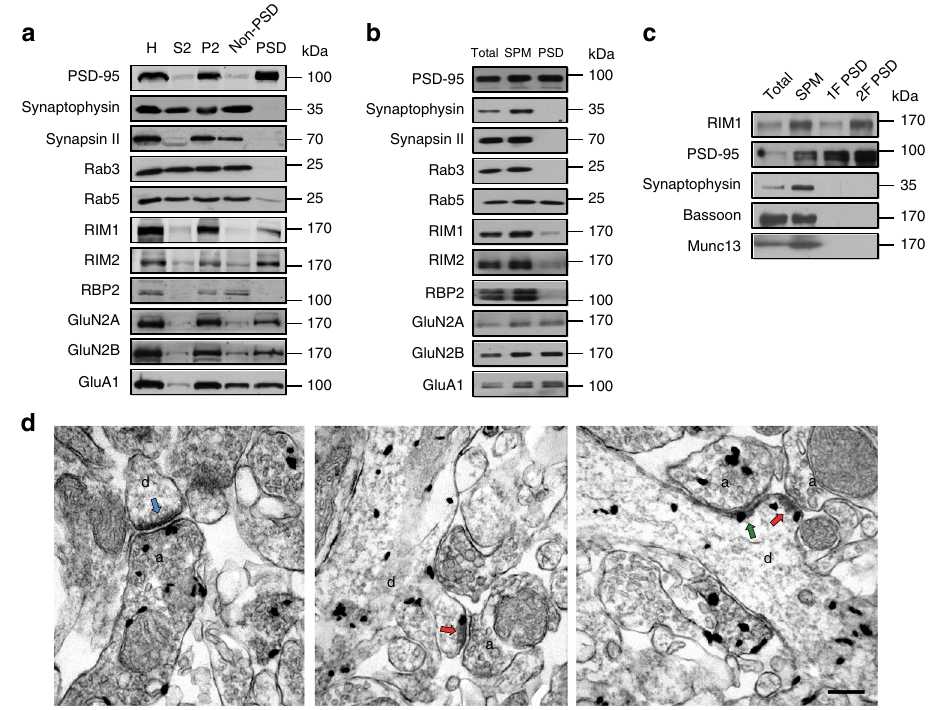
Fig. 1 RIM1 is localized both presynaptically and postsynaptically. a Subcellular fractions of mouse cortex by synaptosome fractionation were probed for the presynaptic marker synaptophysin, the postsynaptic marker PSD-95, the RIM proteins RIM1 and RIM2, the RIM-related protein RBP2, the NMDAR subunits GluN2A and GluN2B, the AMPAR subunit GluA1, and other important synaptic proteins such as synapsin II, Rab3, and Rab5. H homogenates, S2 supernatant after fi rst high-speed centrifugation (12,000× g ), P2 pellet after the fi rst high-speed centrifugation (12,000× g ). b Subcellular fractions of mouse cortex by sucrose gradient centrifugation were probed for synaptophysin, PSD-95, RIM1, RIM2, RBP2, GluN2A, GluN2B, GluA1, and other important synaptic proteins such as synapsin II, Rab3, and Rab5. Total, homogenates; SPM synaptic plasma membrane fraction; PSD postsynaptic density fraction. c Subcellular fractions of mouse cortex by sucrose gradient centrifugation were probed for the presynaptic markers synaptophysin, Munc13, and Bassoon, the postsynaptic marker PSD-95, and RIM1. Total, homogenates; SPM synaptic plasma membrane fraction; PSD postsynaptic density fraction; 1F and 2F are represented as the normal and the 2-fold quantity of the PSD fraction sample, respectively. d Electron micrographs of adult mouse hippocampus stained for RIM1 with immunogold (data from 4 mice). Left: a nanogold-labeled axon terminal makes a synapse with an immunonegative dendritic spine. Middle: an immunonegative axon makes a synapse with a nanogold-labeled dendrite. Right: a nanogold-labeled axon and an immunonegative axon make synapses with a nanogold-labeled dendrite; a axon, d dendrite; blue arrow, synapse with nanogold in the presynaptic pro fi le; red arrow, synapse with nanogold in the postsynaptic pro fi le; green arrow, synapse with nanogold in both the pre- and postsynaptic pro fi les. All arrows point to the PSD. Scale bar, 200 (Fig. 2a). Whole-cell patch-clamp recordings were made from the infected CA1 pyramidal cells in acute slices 10 to 15 days after virus injection (Supplementary Fig. 4a). Paired-pulse facilitation (PPF) is a transient form of plasticity commonly used as a measure of presynaptic function 43 and RIM1 KD had no effect on PPF compared to neurons infected with control RNAi (Fig. 2b). In contrast, when we injected the lentivirus into the CA3 region and recorded PPF from the CA1 pyramidal cells, we found that presynaptic RIM1 KD in area CA3 signi fi cantly affected PPF in area CA1 (control RNAi, 2.0 ± 0.1, n = 9, 4 mice; RIM1 RNAi, 3.1 ± 0.5, n = 10, 4 mice; p < 0.05; Supplementary Fig. 4b and c), in accord with the previous fi nding that presynaptic RIM1 is – 31 . These results are critical for neurotransmitter release 29 consistent with our hypothesis that RIM1 KD occurs only postsynaptically at the synapses being studied when lentivirus is injected into the CA1 region. mediated miniature excitatory postsynaptic currents (AMPAR- mEPSCs). Neither the frequency nor the amplitude of mEPSCs was affected by RIM1 KD (mean frequency: control RNAi, 0.8 ± 0.1 Hz, n = 9, 5 mice; RIM1 RNAi, 0.8 ± 0.2 Hz, n = 9, 5 mice; p > 0.05; mean amplitude: control RNAi, 17.7 ± 1.8 pA, n = 9, 5 mice; RIM1 RNAi, 17.6 ± 0.7 pA, n = 9, 5 mice; p > 0.05; Fig. 2c). To explore whether postsynaptic RIM1 KD in fl uences basal NMDAR-